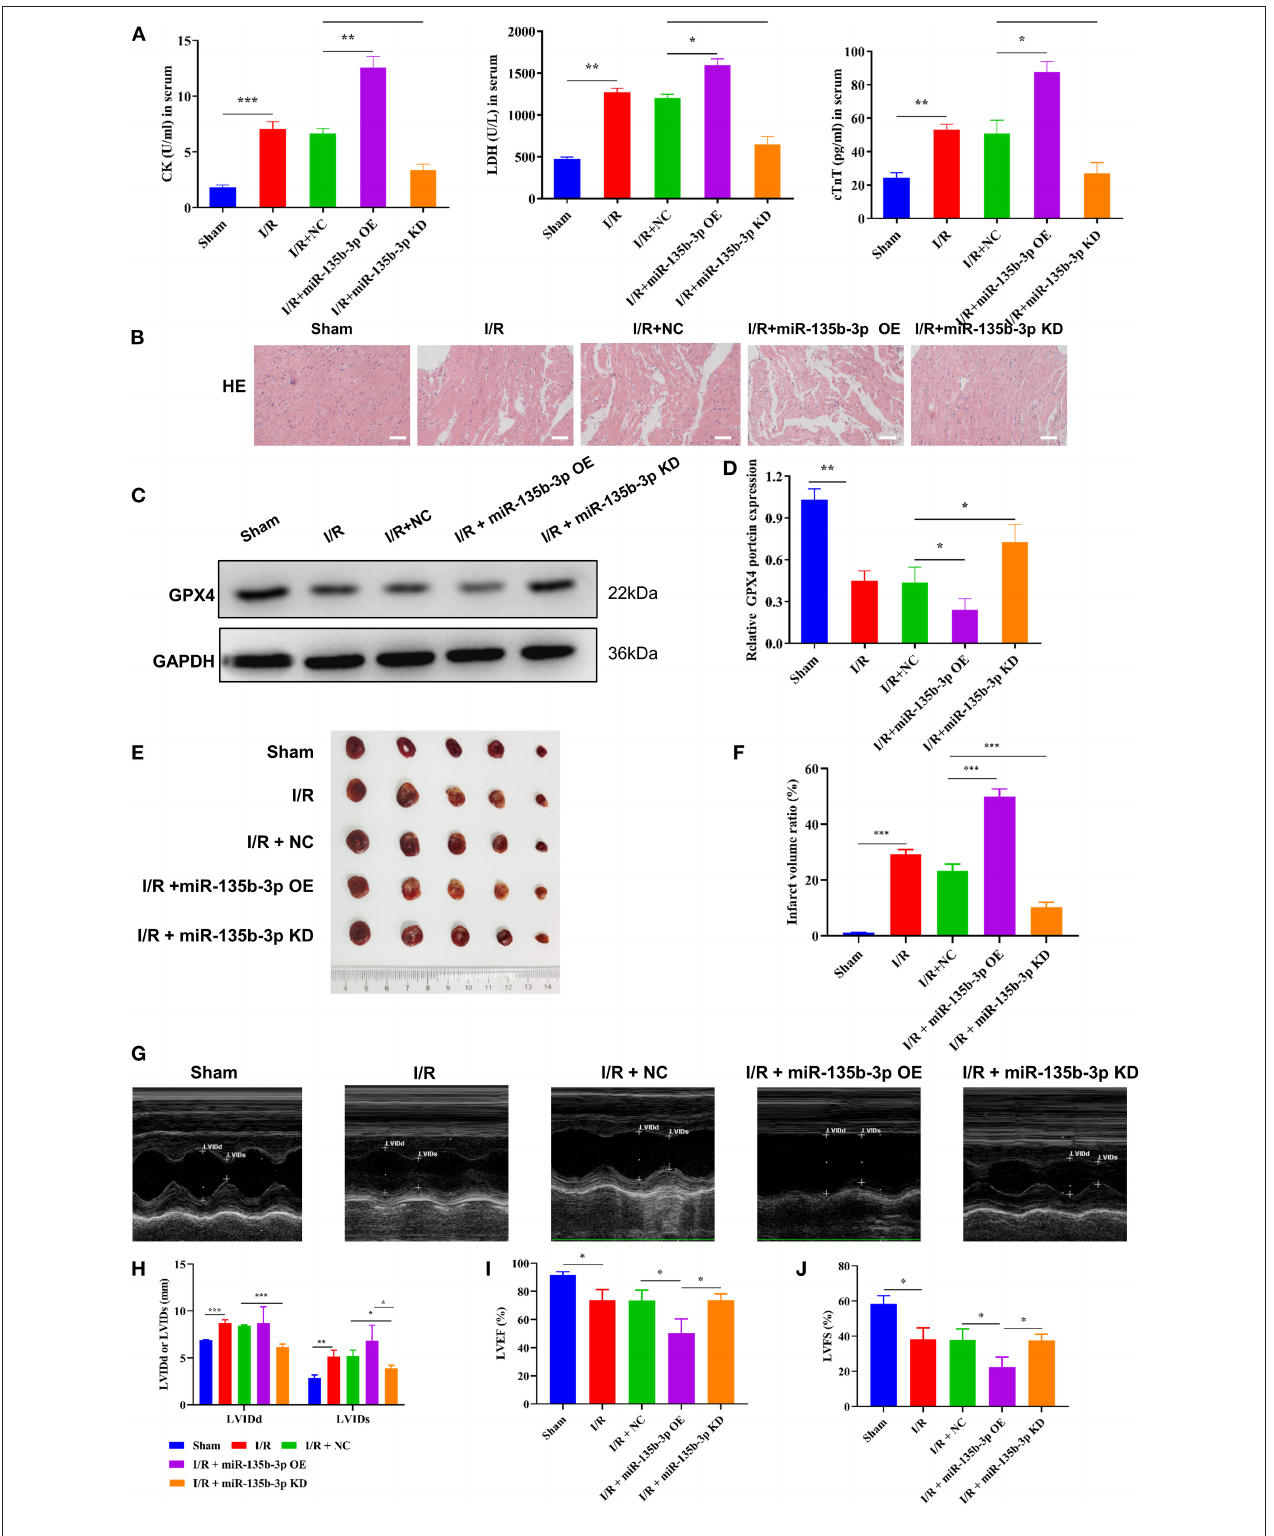
FIGURE 6 | miR-135b-3p enhances ferroptosis by reducing GPX4 expression in vivo , ultimately exacerbating myocardial I/R injury. This part of the study was based on sham and I/R rats, where miR expression in I/R rats was regulated by lentivirus injection ( n = 6). (A) The expression of CK, LDH, and cTnT in serum was